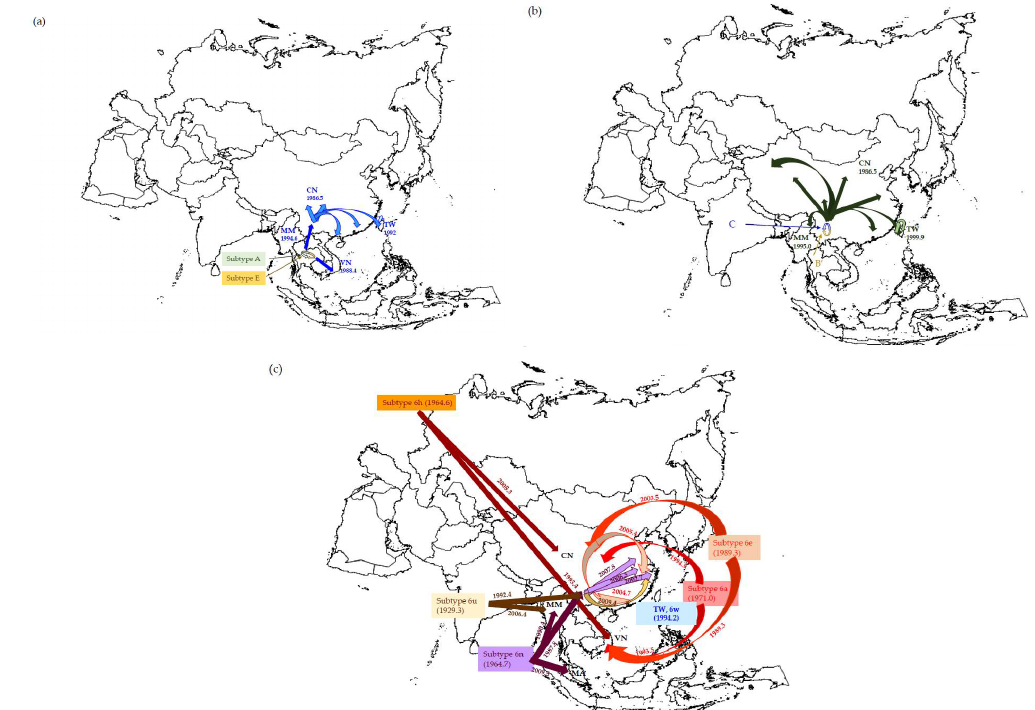
Figure 1. The estimated timescale of the spread of ( a ) HIV-1 CRF01_AE, ( b ) CRF07_BC, and ( c ) HCV genotype-6 in Asian PWID population (CN: China, MM: Myanmar, MA: Malaysia, TW: Taiwan, and VN: Vietnam). In this particular figure, we adopted the data set based on GTR + Γ 6 /GTR + Γ 6 + I constant model to show the tMRCAs of HIV-1 and HCV strains circulating in this area.